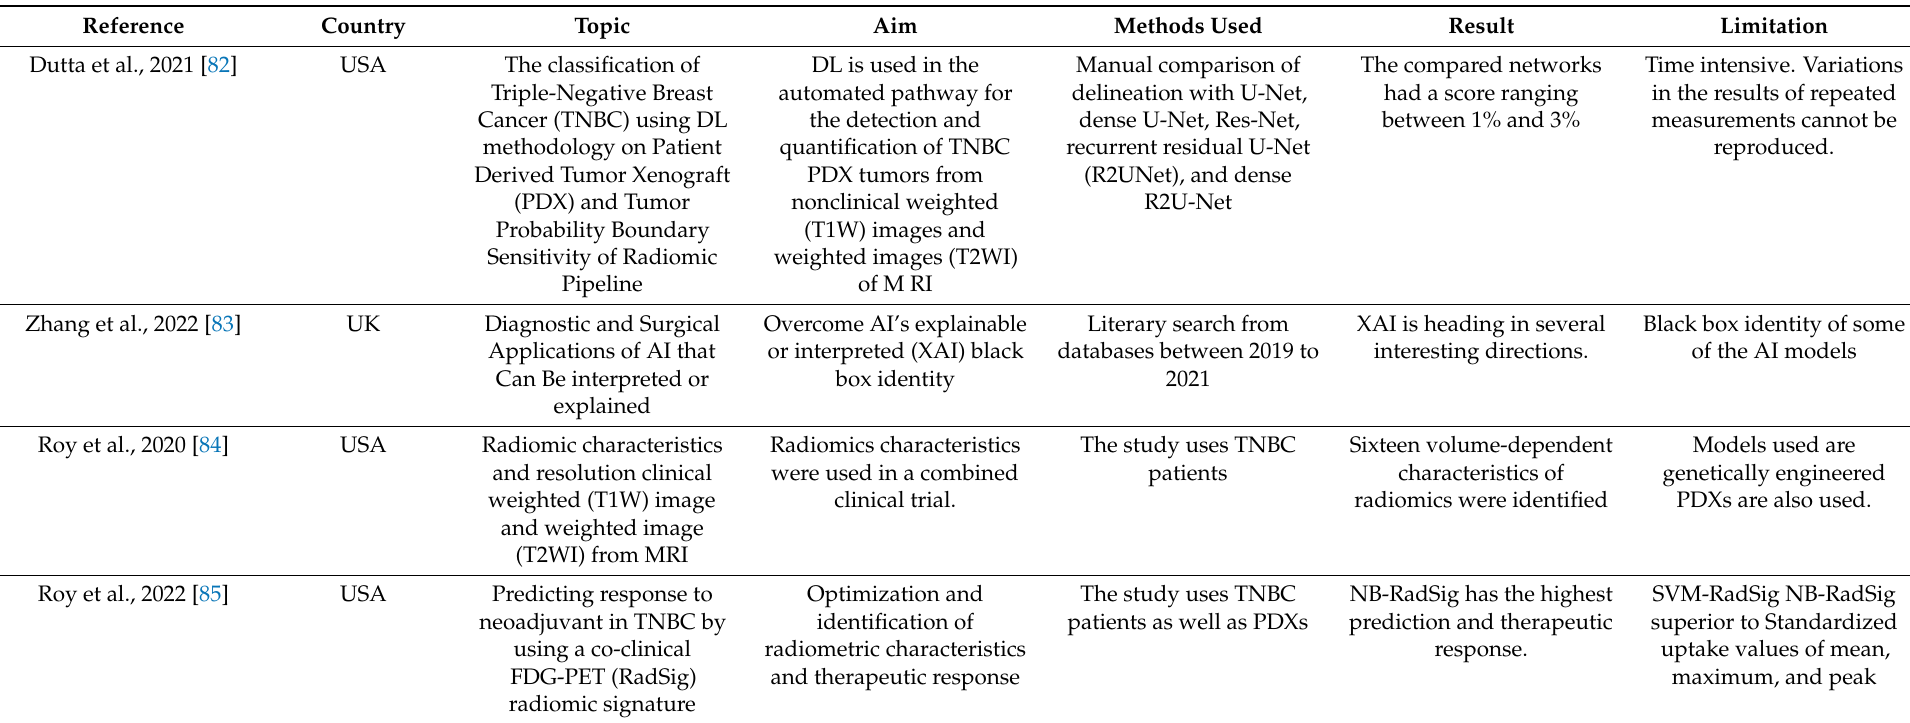
Table 3. Comparison of the latest related